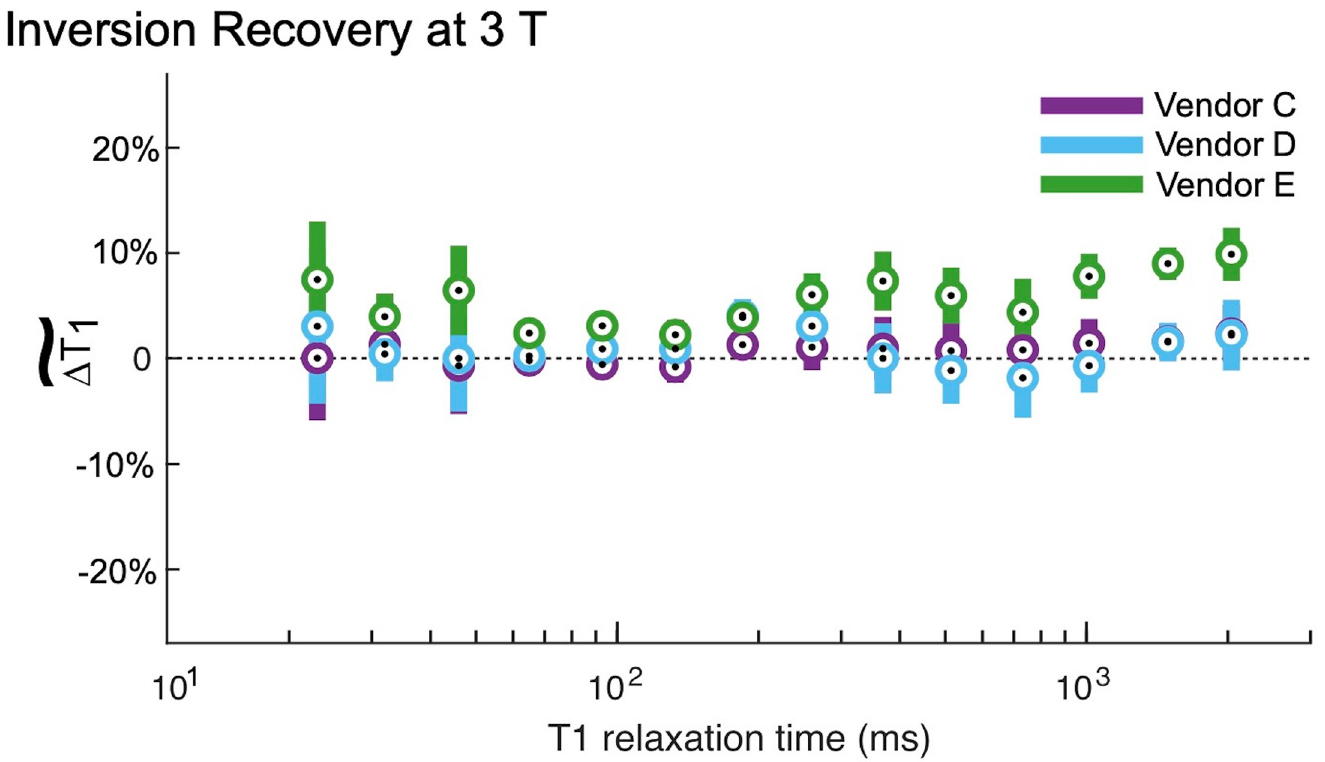
Fig 3. Inversion recovery measurements at 3 T. At 3 T, the inversion recovery (IR) measurements generally overestimated the T 1,NMR . The circles represent the within group means, and the error bars are 95% confidence intervals about these means. There were no differences between vendors C and D. By contrast, vendor E is biased almost 10% higher than vendors C and D for T 1 values in the physiologically relevant range. Please see Table 5 for tests of significance.